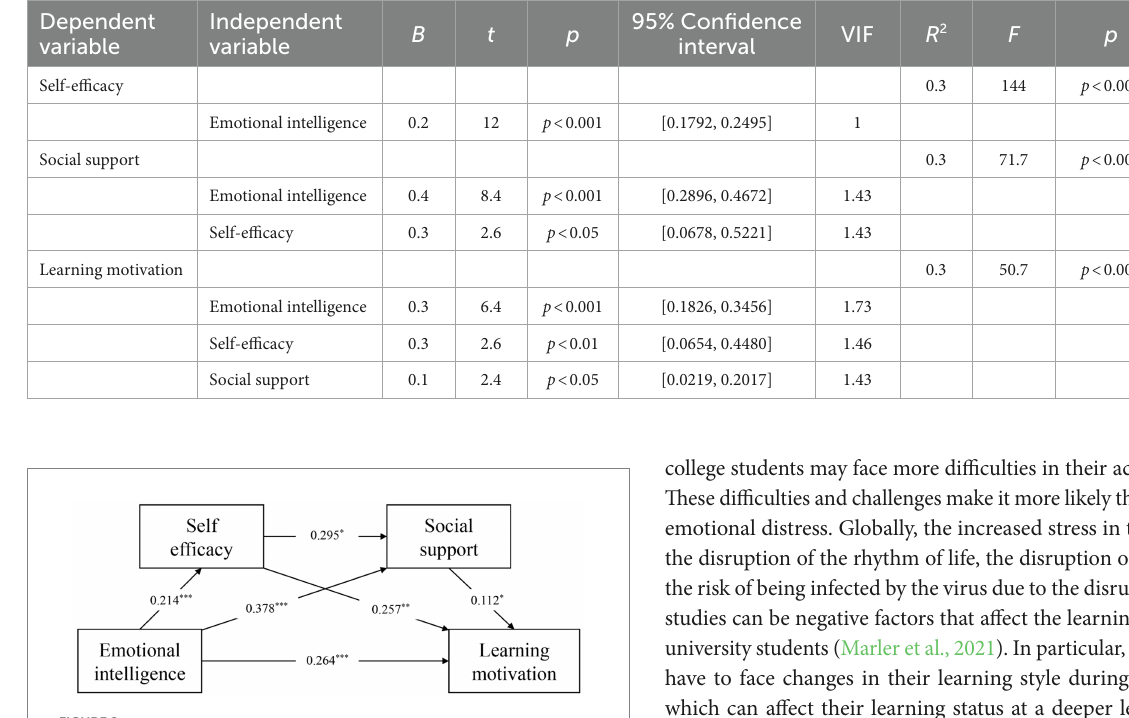
FIGURE 2 Analysis of the coefficients of the mediated pathways. * p < 0.05, ** p < 0.01, *** p <